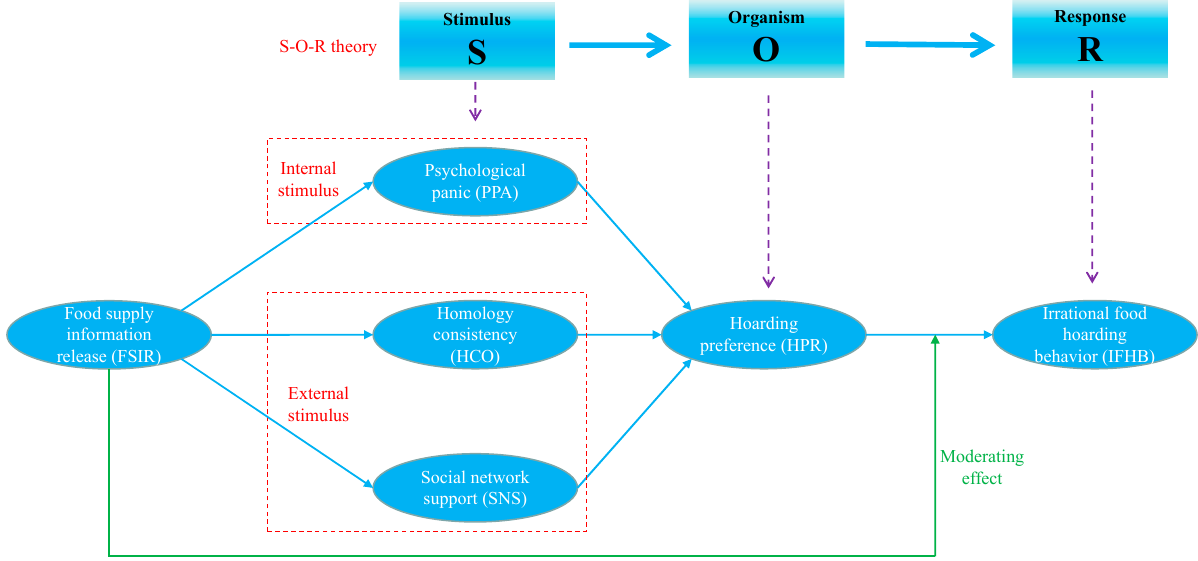
Figure 2. The research framework of this study.